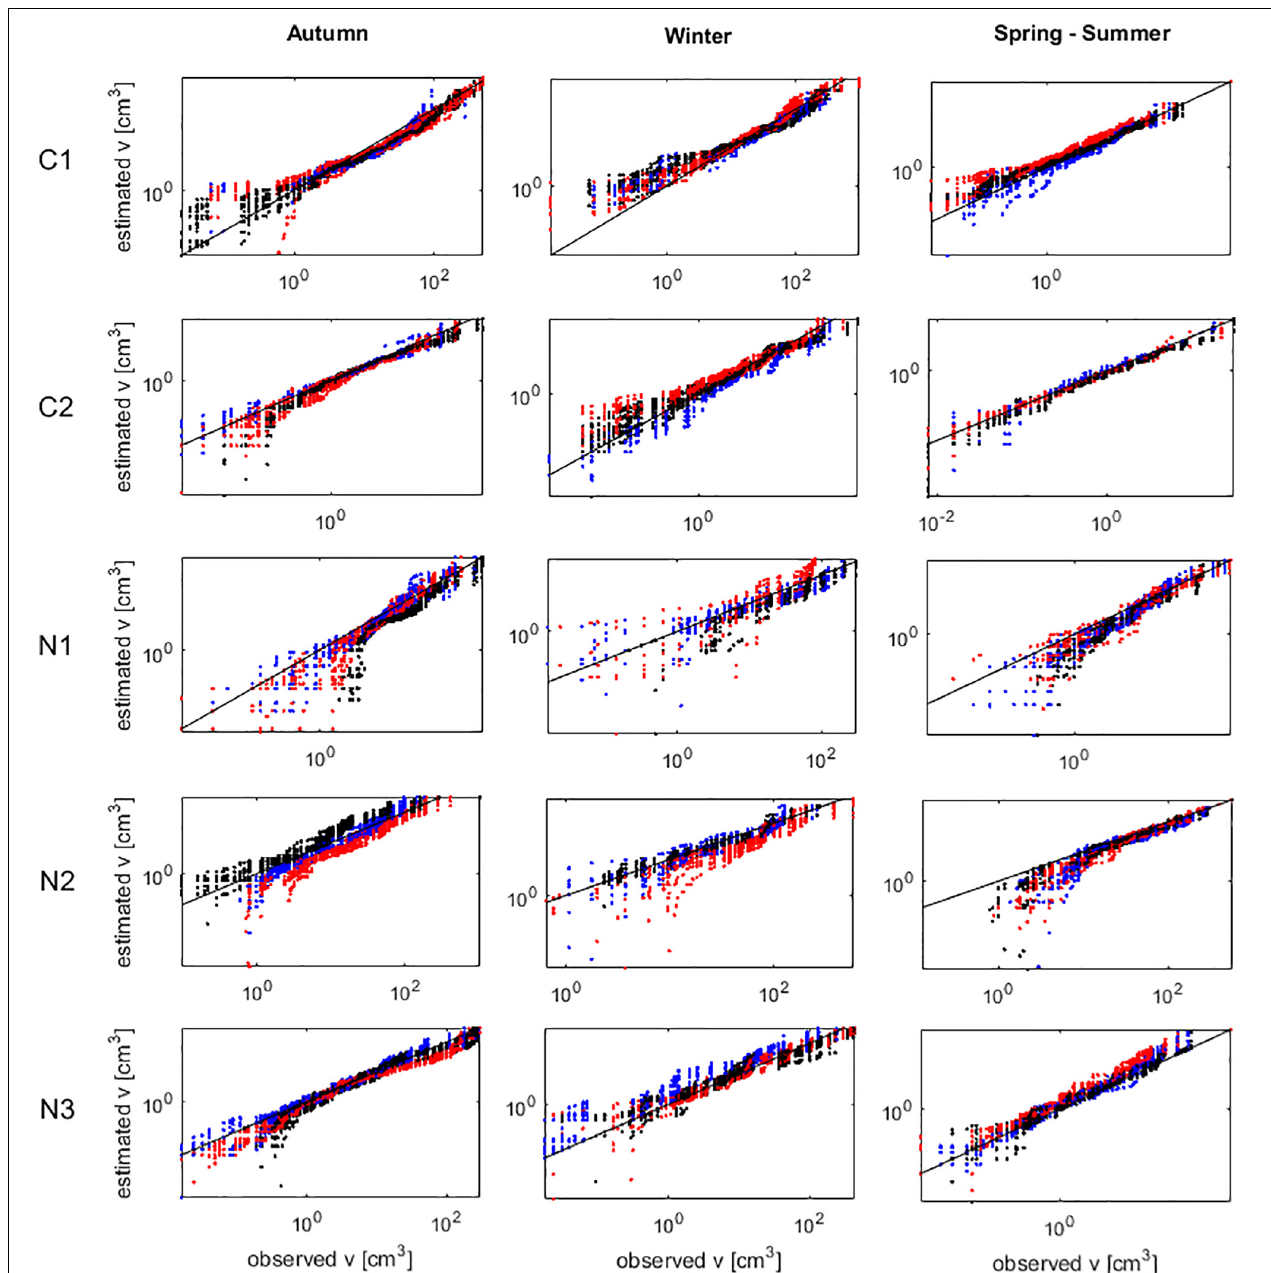
FIGURE 6 | Agarophyton chilense IBM calibration and validation of frond size (v) estimates. Observed size compared against size predicted from 10 runs of the IBM. Oblique black lines represent the 1:1 line identifying the perfect match between predictions and observations. Male haploids (blue), female haploids (red), and diploids (black). Plots were Corral 1 (C1), Corral 2 (C2), Niebla 1 (N1), Niebla 2 (N2), and Niebla 3